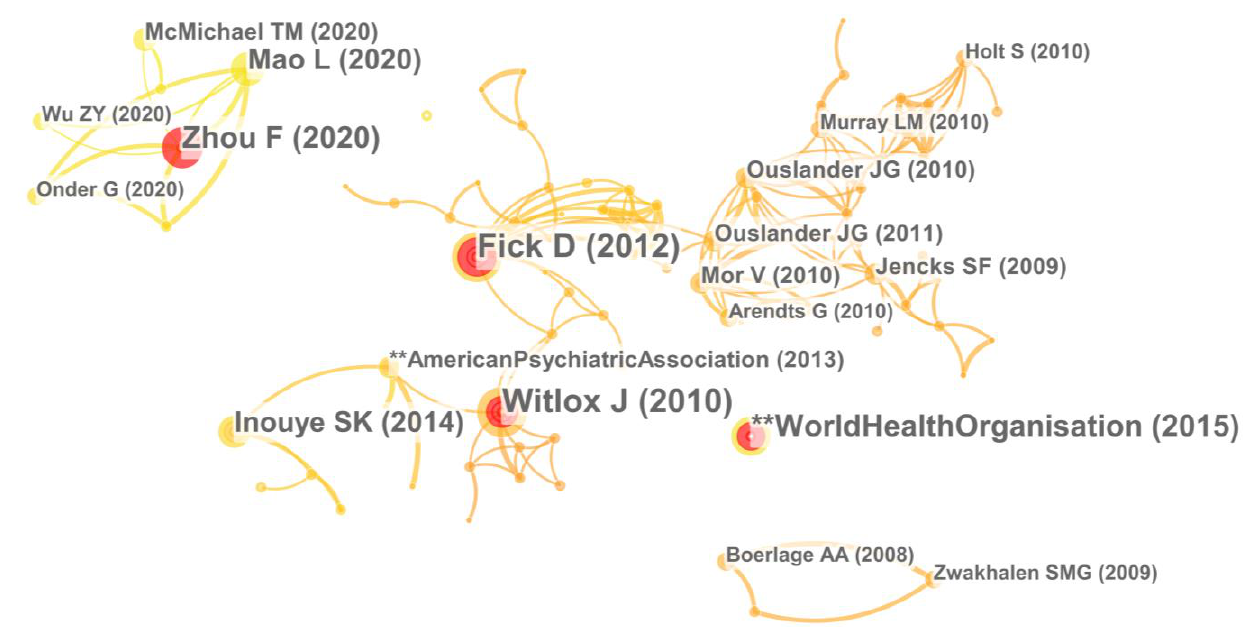
Figure 7. Temporal distribution map of FCMNCE research keywords.